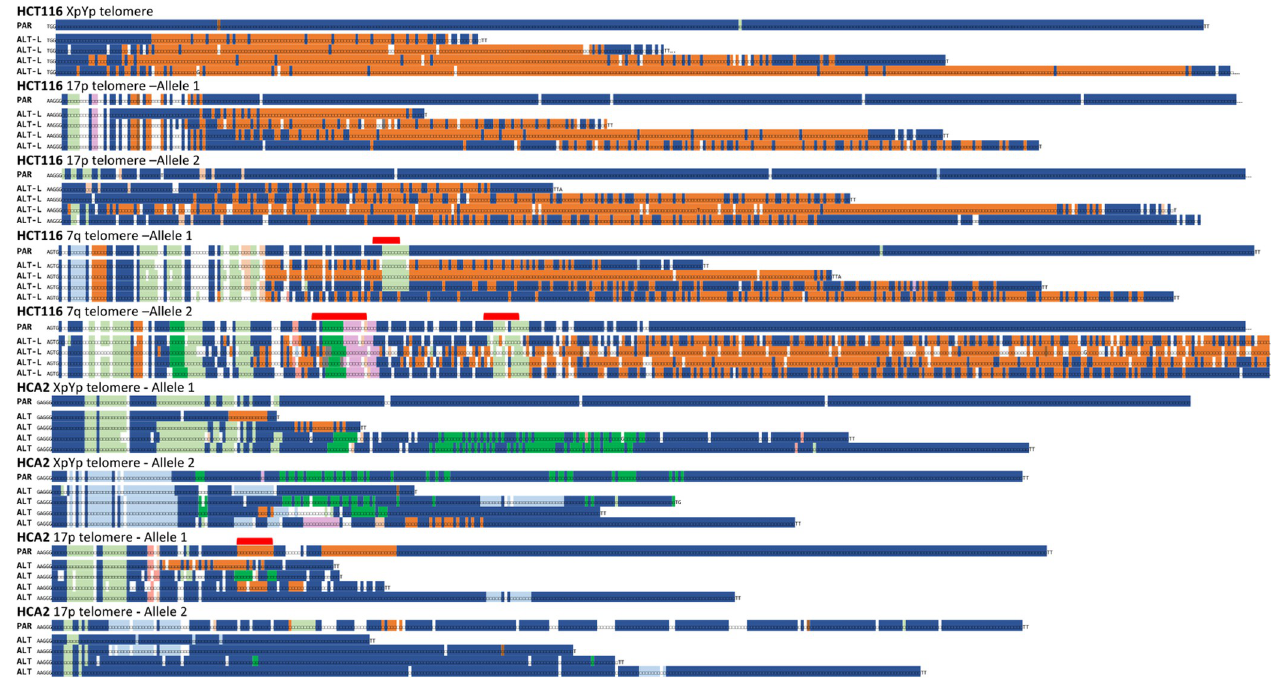
Fig 5. ALT elongation arises from multiple independent events. Examples of telomere sequences obtained from PacBio sequencing of STELA amplicons obtained from HCT116 ATRX-/o and HCA2 HPVE6E7;ATRX-/o cells at the XpYp, 17p and 7q chromosome ends prior to crisis (Parental) and a single clone of each exhibiting characteristics of ALT post crisis, denoted as ALT from HCA2 HPVE6E7;ATRX-/o fibroblasts and ALT-L (ALT-like) from HCT116 ATRX-/o . Each telomeric allele is displayed separately with the parental (PAR) telomeric allele above and the derived ALT allele (ALT) below. The red bar displayed above the parental allele sequences indicates distinct TVR patterns conserved in ALT alleles. The telomere and 6 nt TVR sequences are coded as follows: dark blue □ = TTAGGG; light blue □ = TCAGGG; dark orange □ = TTCGGG; beige □ = GTAGGG; dark green □ = TGAGGG; light green □ = TTGGGG; ochre □ = TAAGGG; lilac □ = CTAGGG; brown □ = TTTGGG; yellow □ = AGAGGG; white □ TVRs ≶ 6 nt.